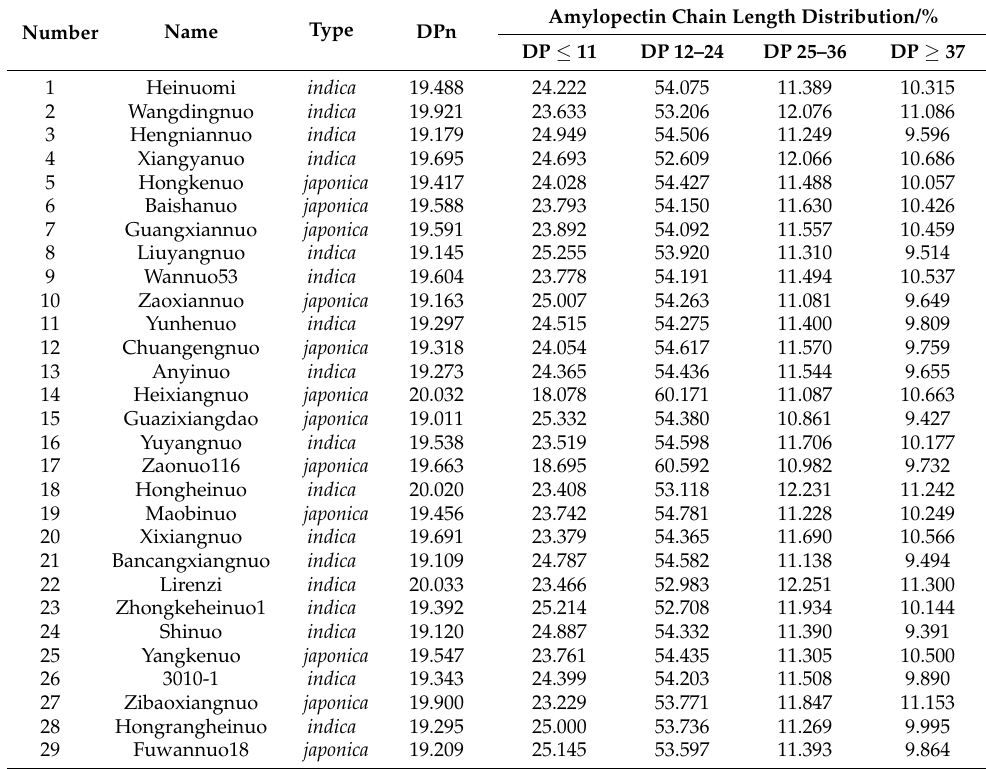
Table 2. Distribution of amylopectin chain length in the 29 glutinous rice varieties.